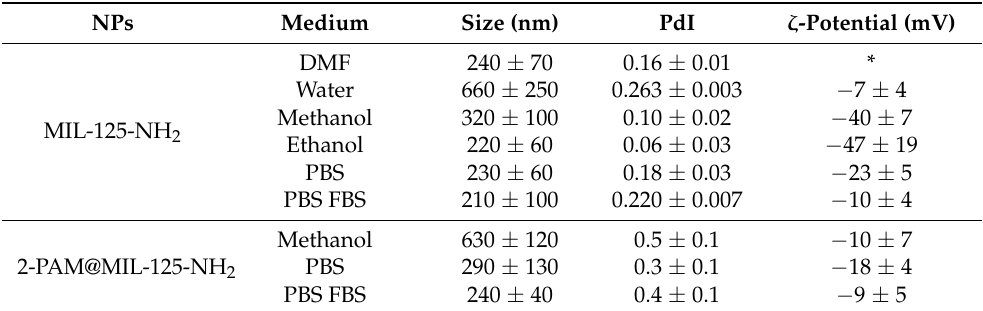
Table 1. Particle size and ζ -potential (with standard deviation) of the MIL-125-NH 2 non-toxic nanoparticles (NPs) in different media at 20 ◦